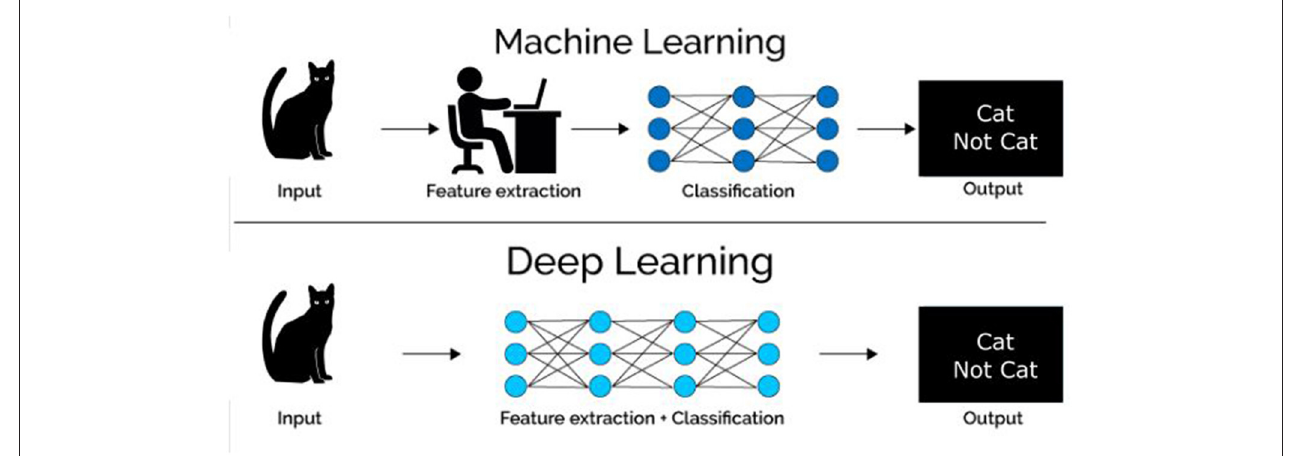
FIGURE 4 | Visual example of the differences between machine learning (ML) and deep learning (DL)